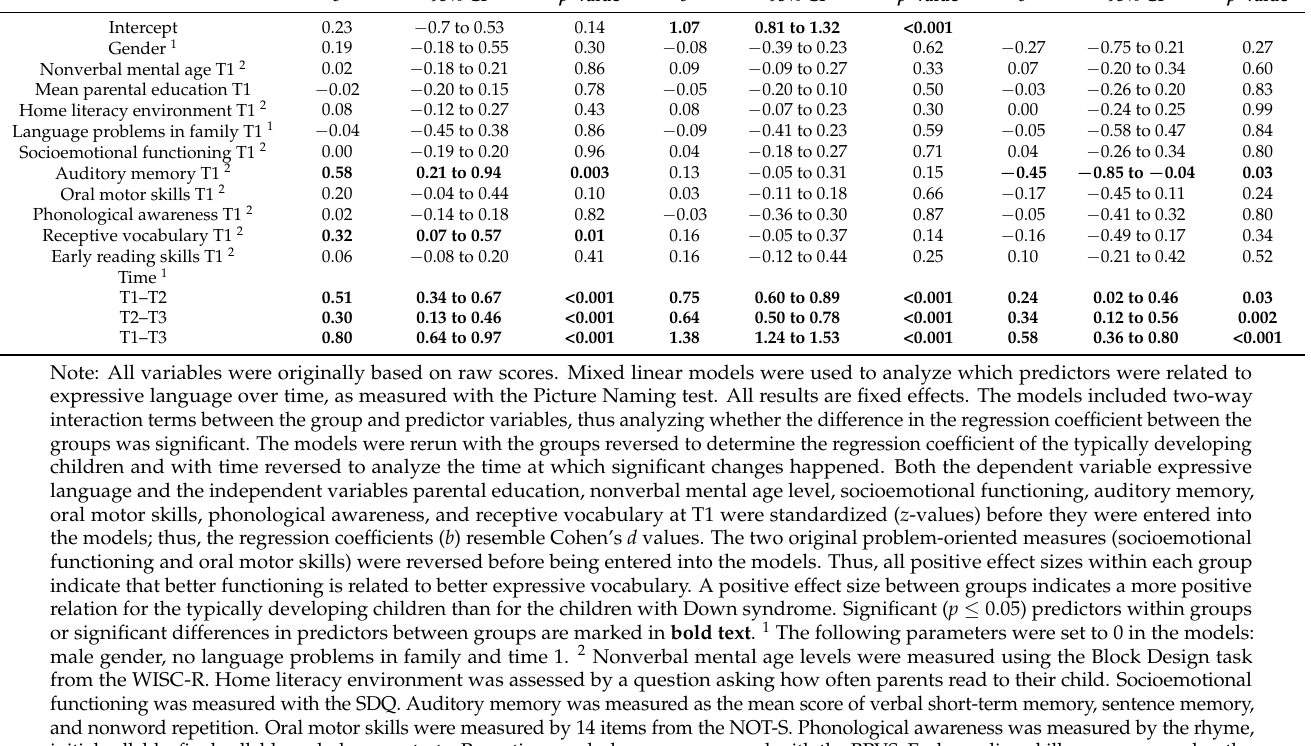
between Groups ( n =